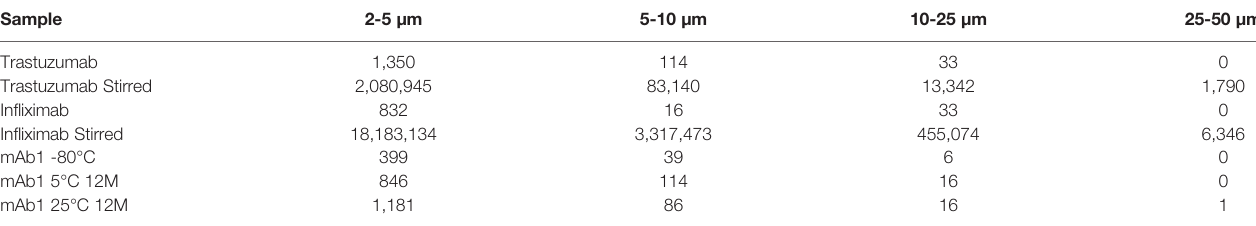
TABLE 2 | Micro fl ow imaging analysis of antibody aggregates: Comparison of spontaneously forming aggregates from drug stability testing. Sample